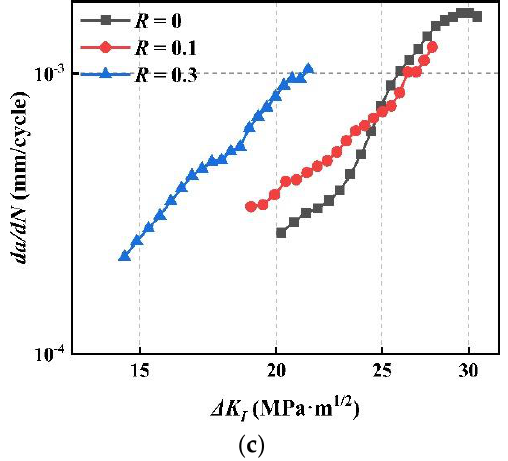
Figure 9. Wher e β = 60°, the relationship between FCGR and ∆ K I under different biaxial load ratios Figure 8. Where β = 90 ◦ , the relationship between FCGR and ∆ K I under different biaxial load ratios ( a ) λ = 0 ( b ) λ = 0.5 ( c ) λ = 1. ( a ) λ = 0 ( b ) λ = 0.5 ( c ) λ = 1.